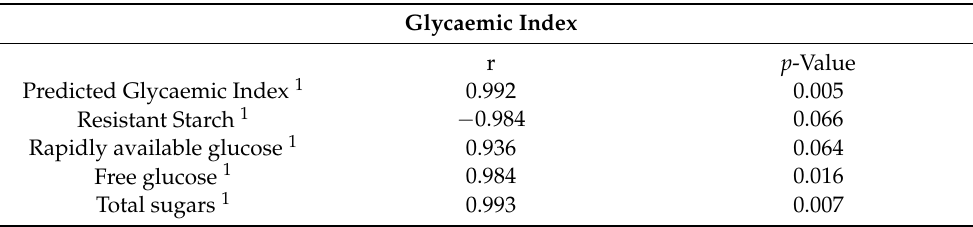
Table 3. Pearson’s correlation coefficients between the in vivo glycaemic index and the predicted glycaemic index, resistant starch, rapidly available glucose, free glucose and total